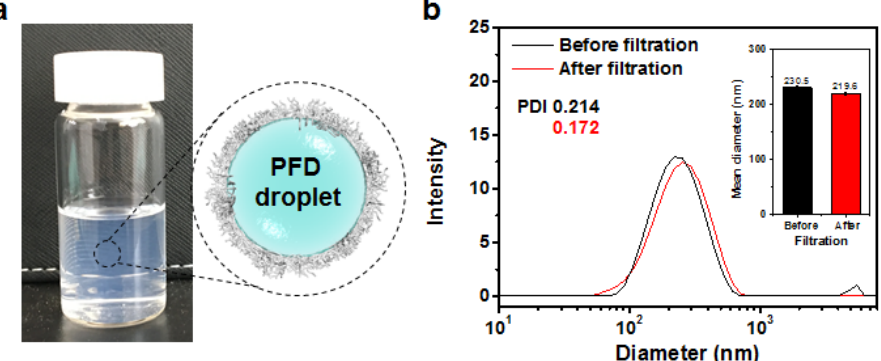
Figure 2. Digital image and schematic representation of aqueous dispersion of PFD nanodroplets stabilized with ssABP in aqueous PBS solution ( a ) and DLS diagrams and mean diameters (inset) of nanodroplets prepared at 18/0.31 wt/wt of ssABP/PFD in PBS solution before and after filtration ( b ).